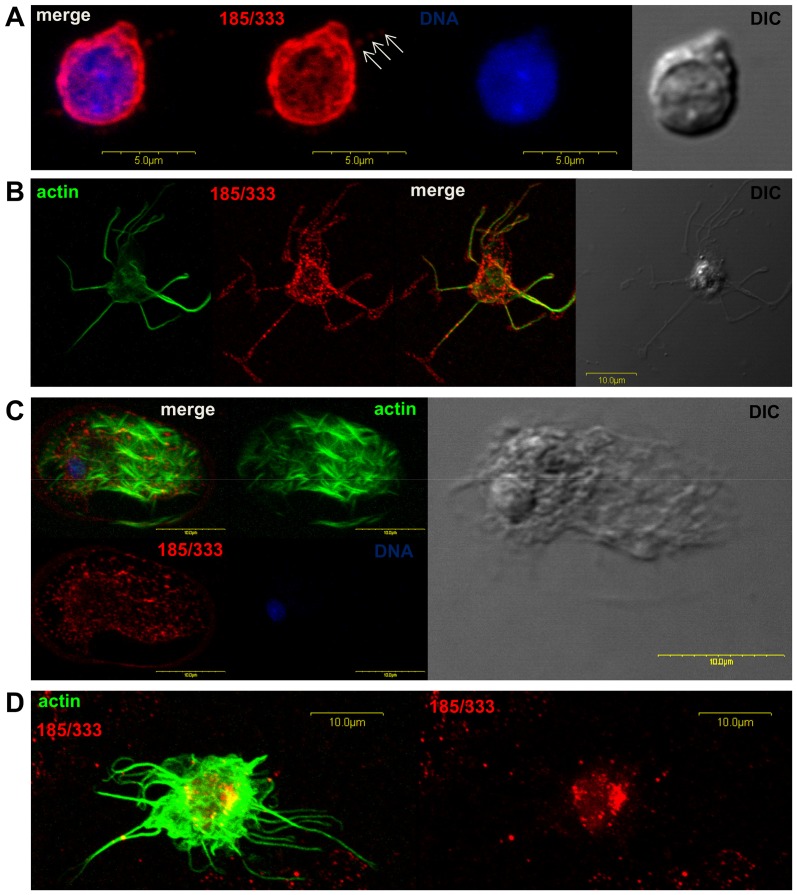
Cellular expression of He185/333 proteins.
A–D. Immunofluorescence and differential intereference contrast (DIC) microscopic images of different coelomocyte types expressing He185/333 proteins (red) and actin (green). Nuclear DNA appears in blue. A. A small filopodial amoebocyte expressing He185/333 proteins. He185/333 staining is found on the cell surface and the clustering of He185/333-associated fluorescence in knobs is evident in a filopodium (white arrows). B. A large filopodial amoebocyte expressing He185/333 proteins in dense knobs. He185/333 signals are not uniformly distributed but are found in patches. C. A large filopodial amoebocyte expressing He185/333 within the cell body in perinuclear areas. D. A lamellipodial amoebocyte expressing He185/333 as knobs on the cell surface.